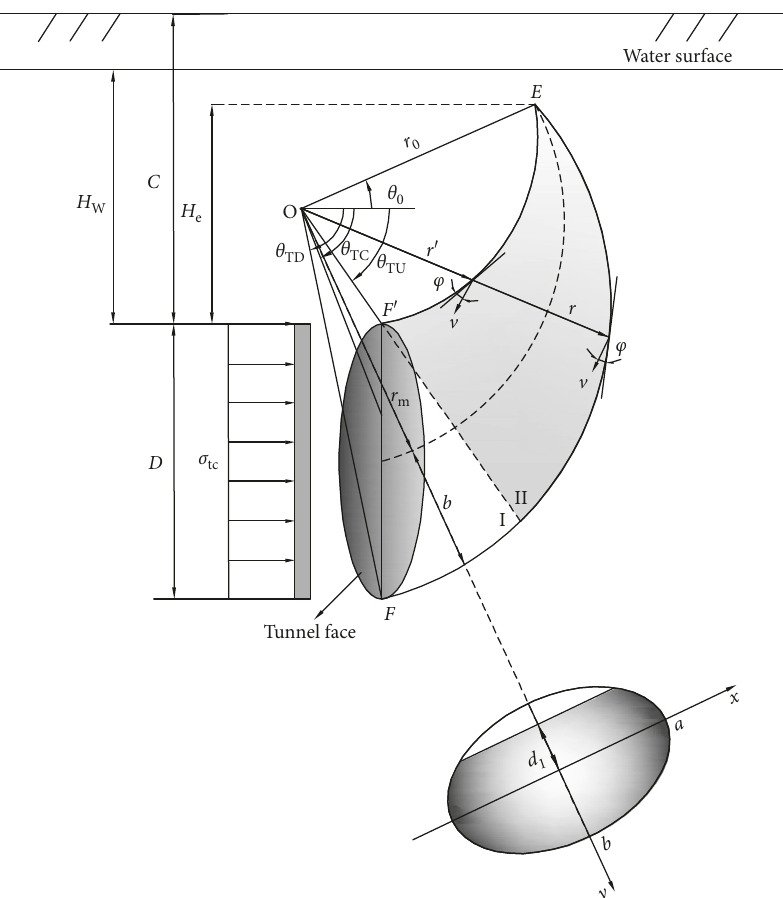
Figure 1: Central cross section of 3D rotational failure mechanism for circular tunnel